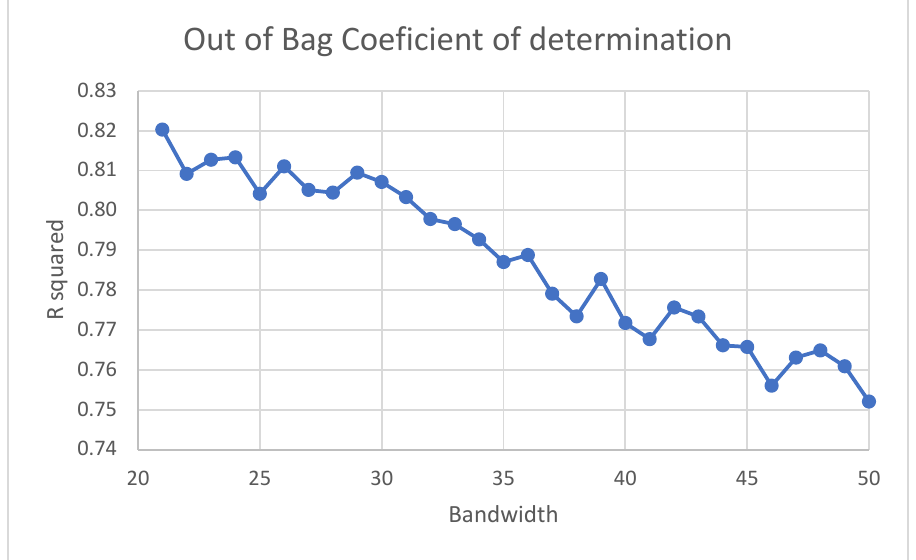
Figure 2. Bandwidth optimization for the GRF models. The out-of-bag (OOB) coefficient of determination peaked using 20 neighbors as a bandwidth value.